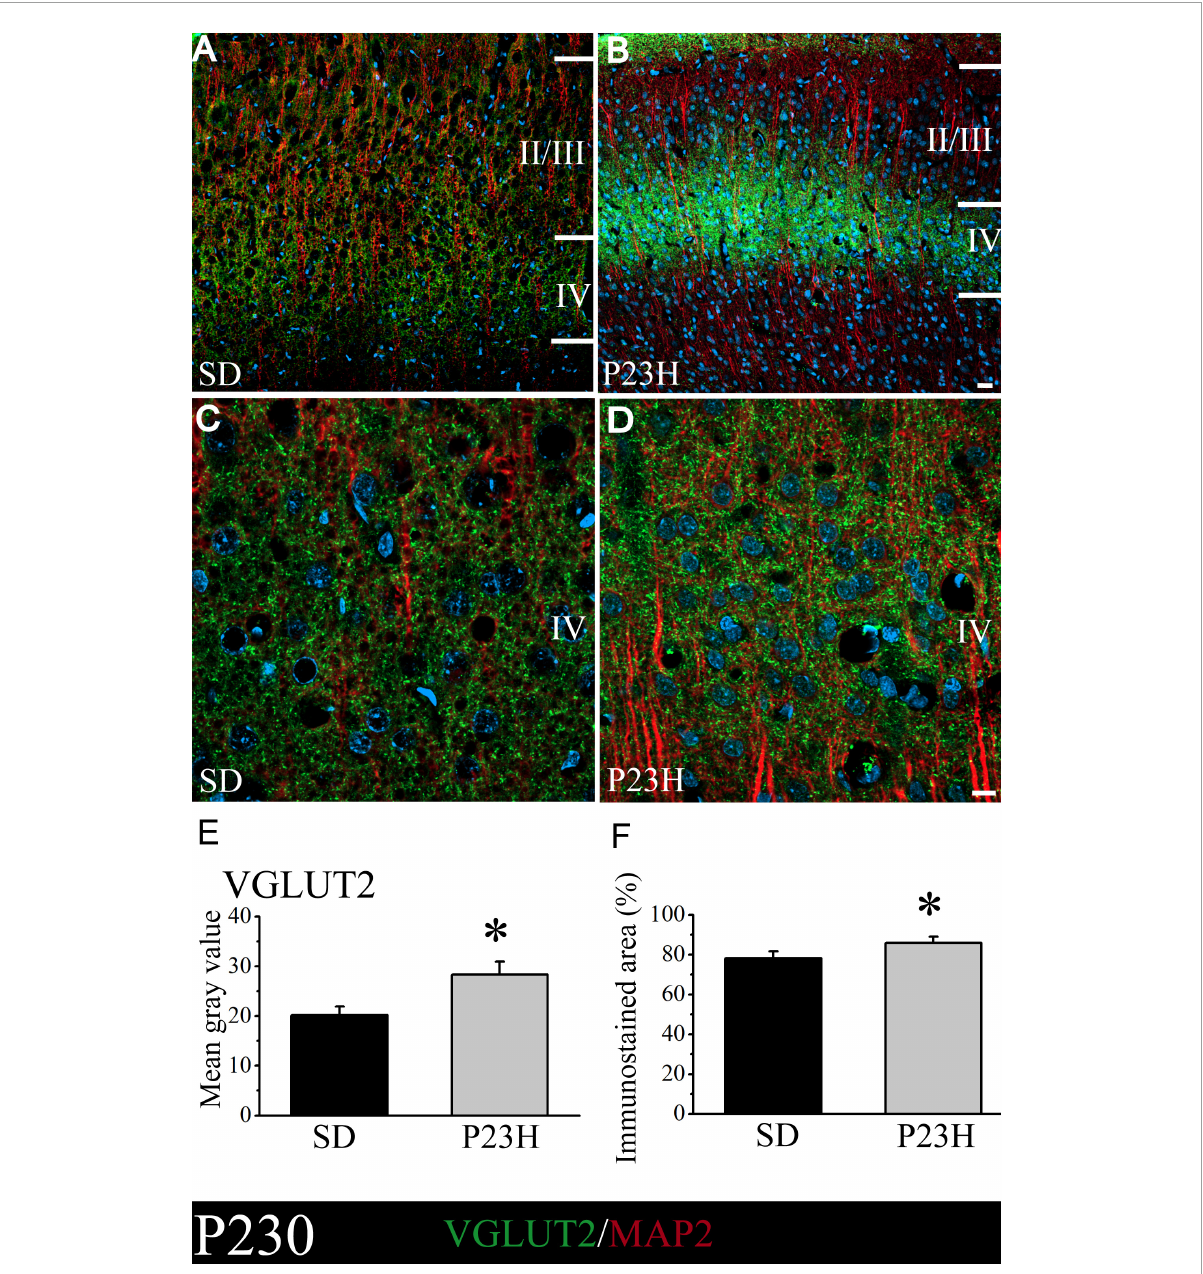
FIGURE5 VGLUT2 and MAP2 immunolabeling in the visual cortices of the SD and P23H rats at P230. Nuclei are counterstained with DAPI (blue). (A,B) Confocal images of the VGLUT2-ir thalamic presynaptic structures (green) and MAP2-ir somata and dendrites (red) along layers II/III and IV of the visual cortices of the adult SD and P23H rats. Layer IV VGLUT2-ir band in P23H was stronger and narrower compared to the SD rats. (C,D) High-magnification confocal images of the VGLUT2 and MAP2 immunolabeling of visual cortical layer IV. (E,F) Quantification of the MGV and % of immunostained areas. In both cases, differences were statistically significant with ∗ p < 0.05 according to the Student’s t -test (E) and the Mann-Whitney U -test (F) . Scale bar: 25 µ m (A,B) ; 10 µ m (C,D) .